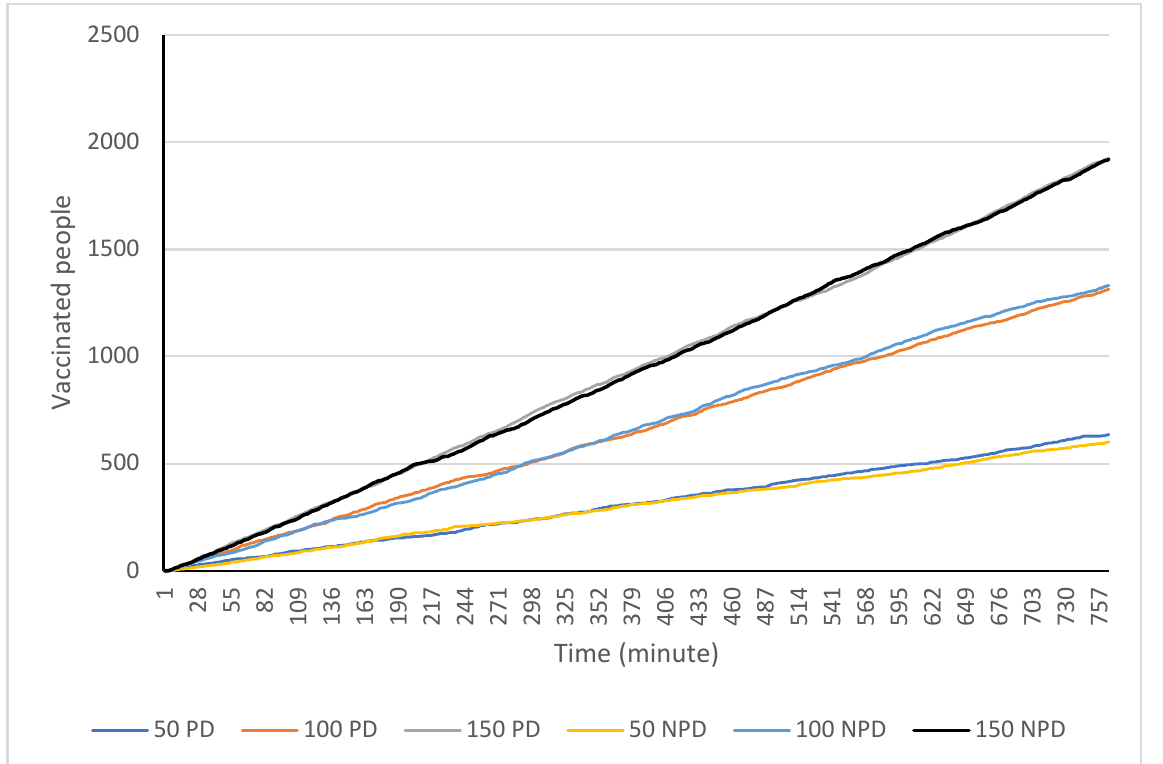
Figure 4. Total number of people vaccinated over the course of 12.75 h at the simulated clinic with and without physical distancing measures in place.